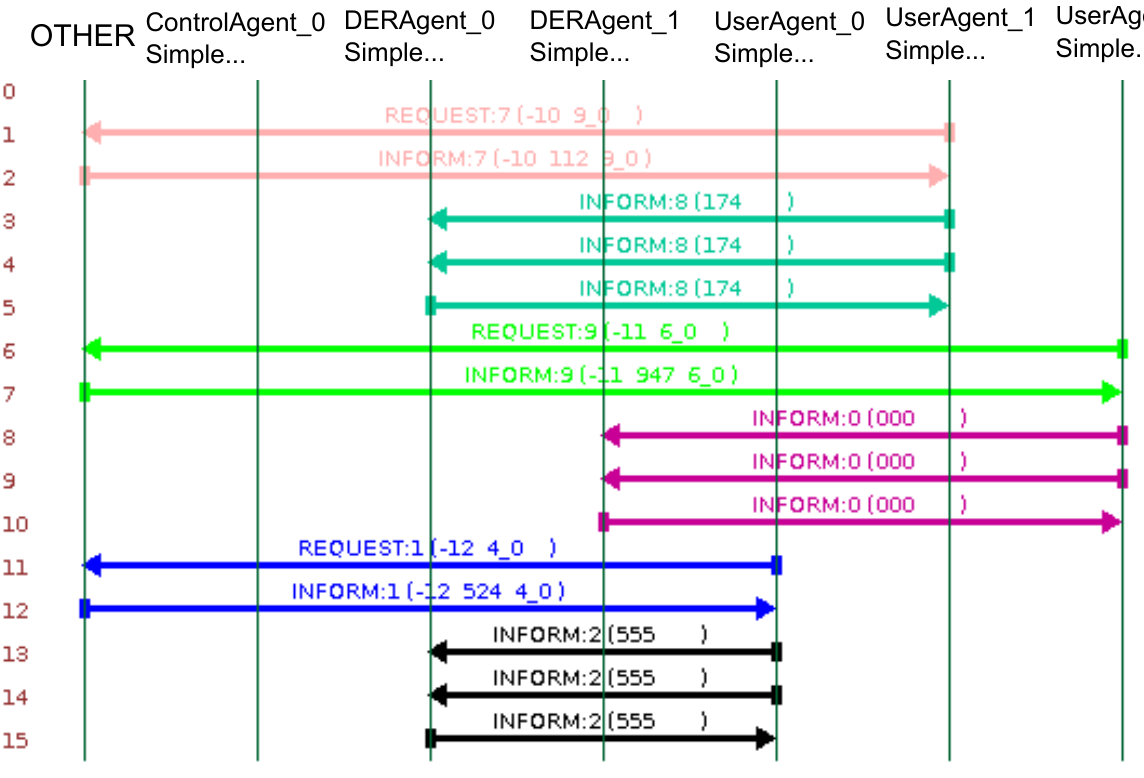
Figure 7. JADE Sniffer showing how the communication among agents is taking